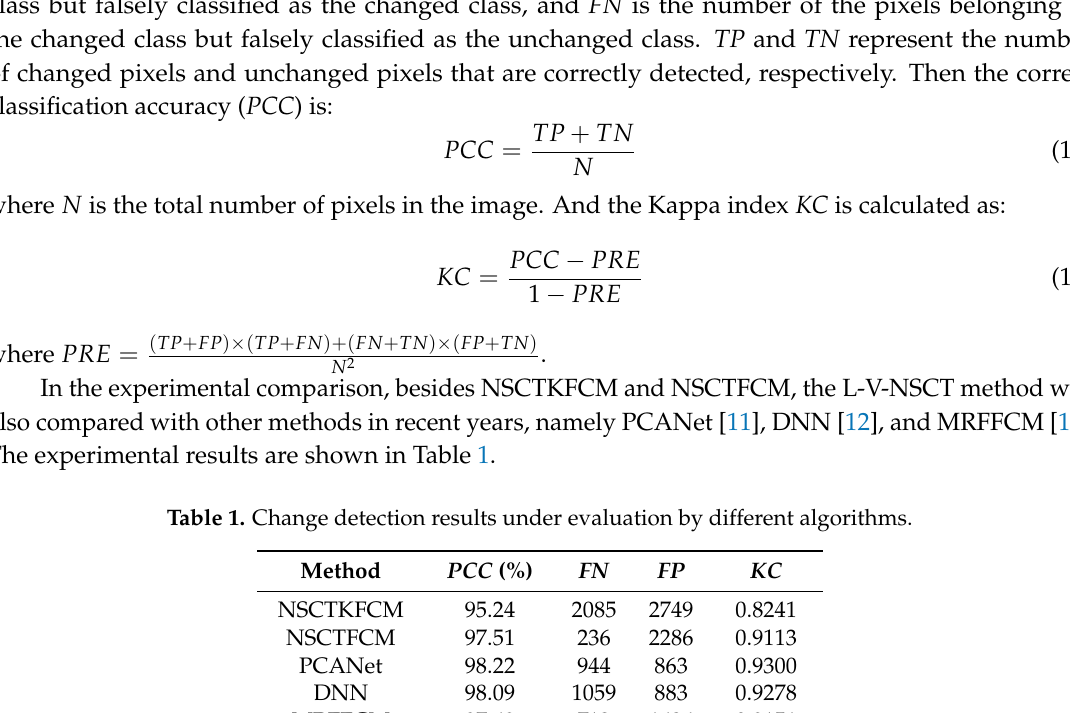
Table 1. Change detection results under evaluation by different algorithms.